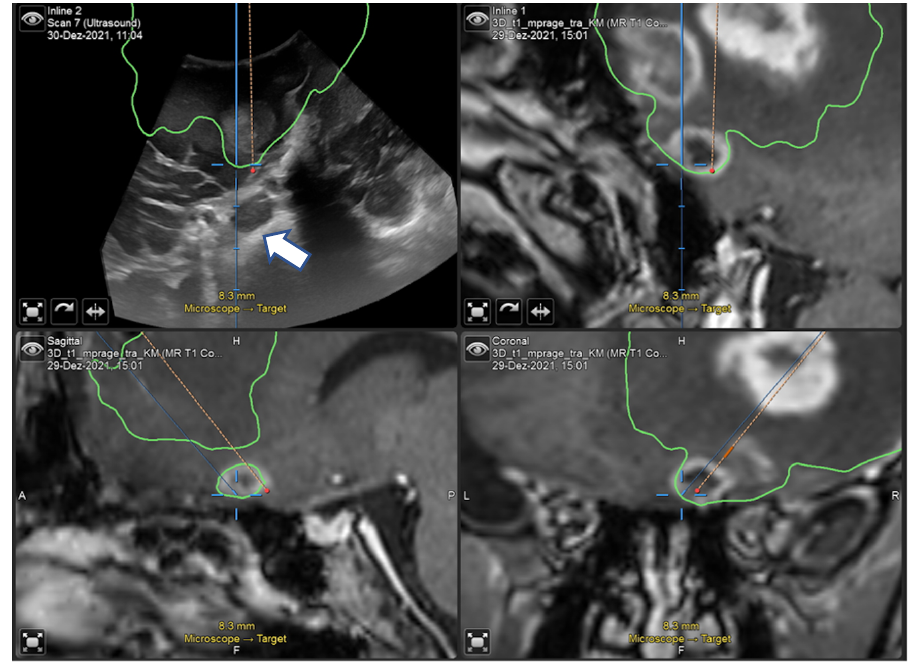
Figure 10. “live” iUS-guided resection at 50% of tumor removal showing the mismatch between the pointer and the real position on iUS (white arrow).